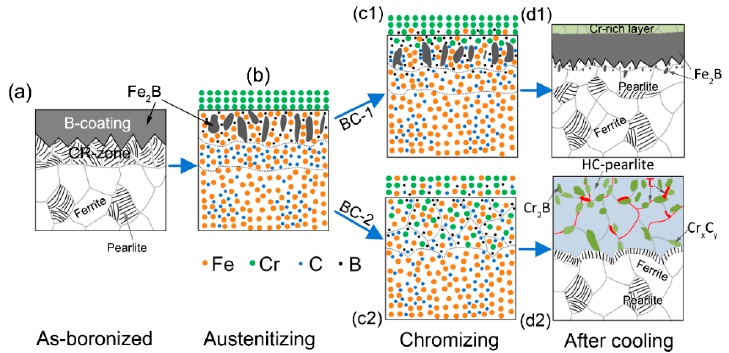
Figure 6. Sketch maps showing atomic diffusion process and microstructure evolution during chromizing after preboronizing: ( a ) before chromizing; ( b ) austenitizing at the beginning of chromizing; ( c1 , c2 ) during chromizing; ( d1 , d2 ) final equilibrium microstructures after cooling to room temperature.